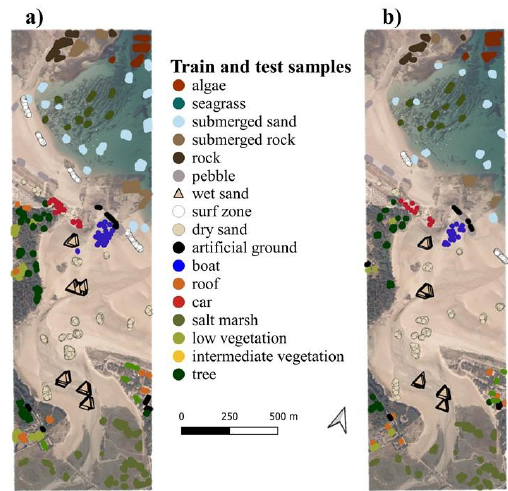
Figure 3. Distribution of the distinct a) train and b) test samples across the studied area (the natural colored imagery was acquired four years prior to the lidar